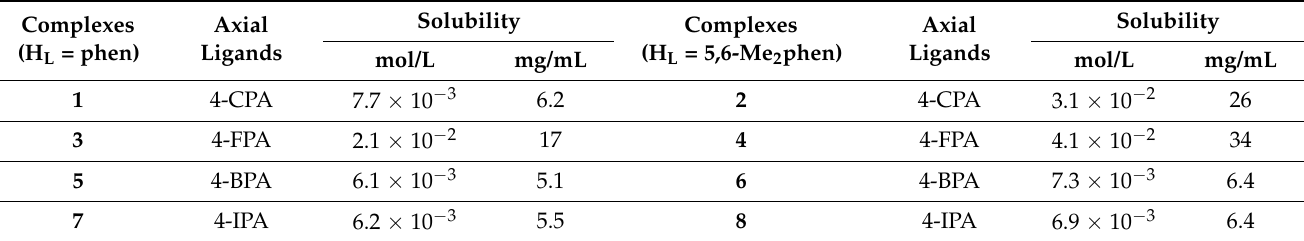
Table 4. Solubility of platinum(IV) complexes ( 1 – 8 ) in d.i.H 2 O at room temperature, expressed in mol/L and